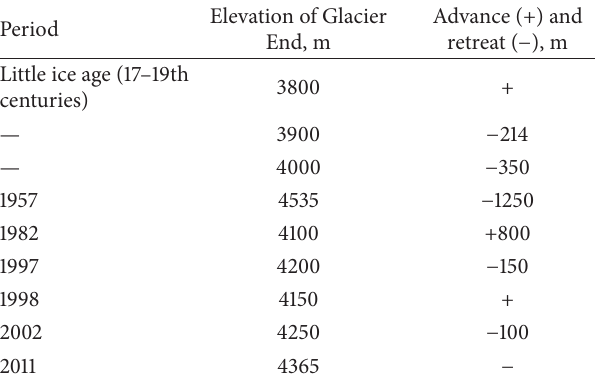
Table 1: Changes of the terminus of Glacier-BS1 since the little ice age (data sources [24,